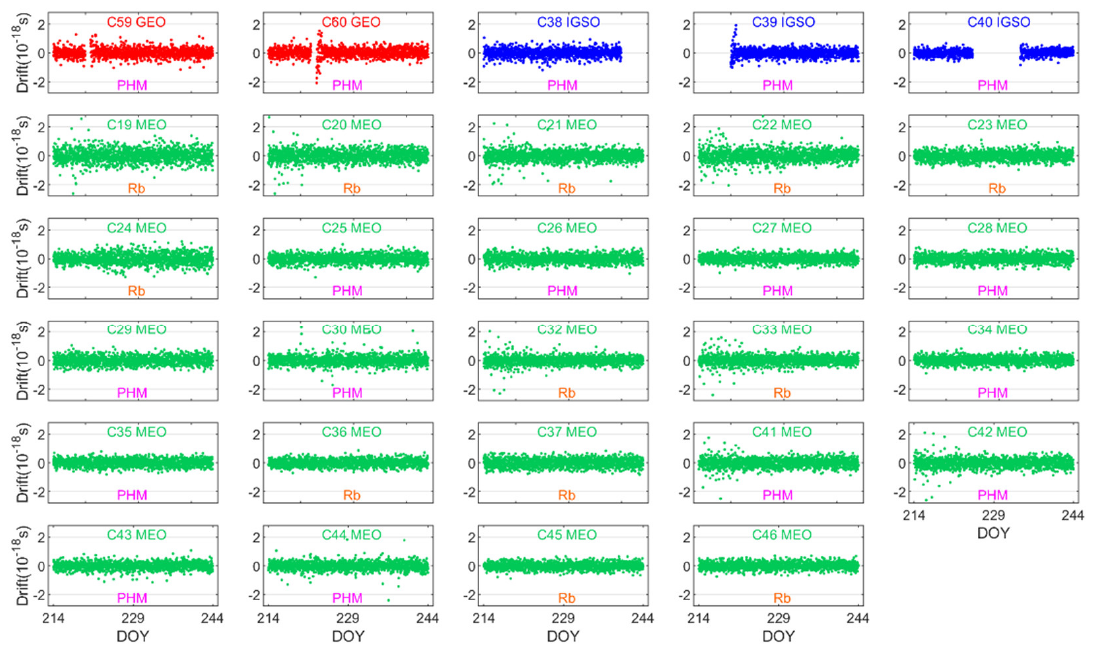
Figure 10. Frequency drift series of BDS-3 satellites.